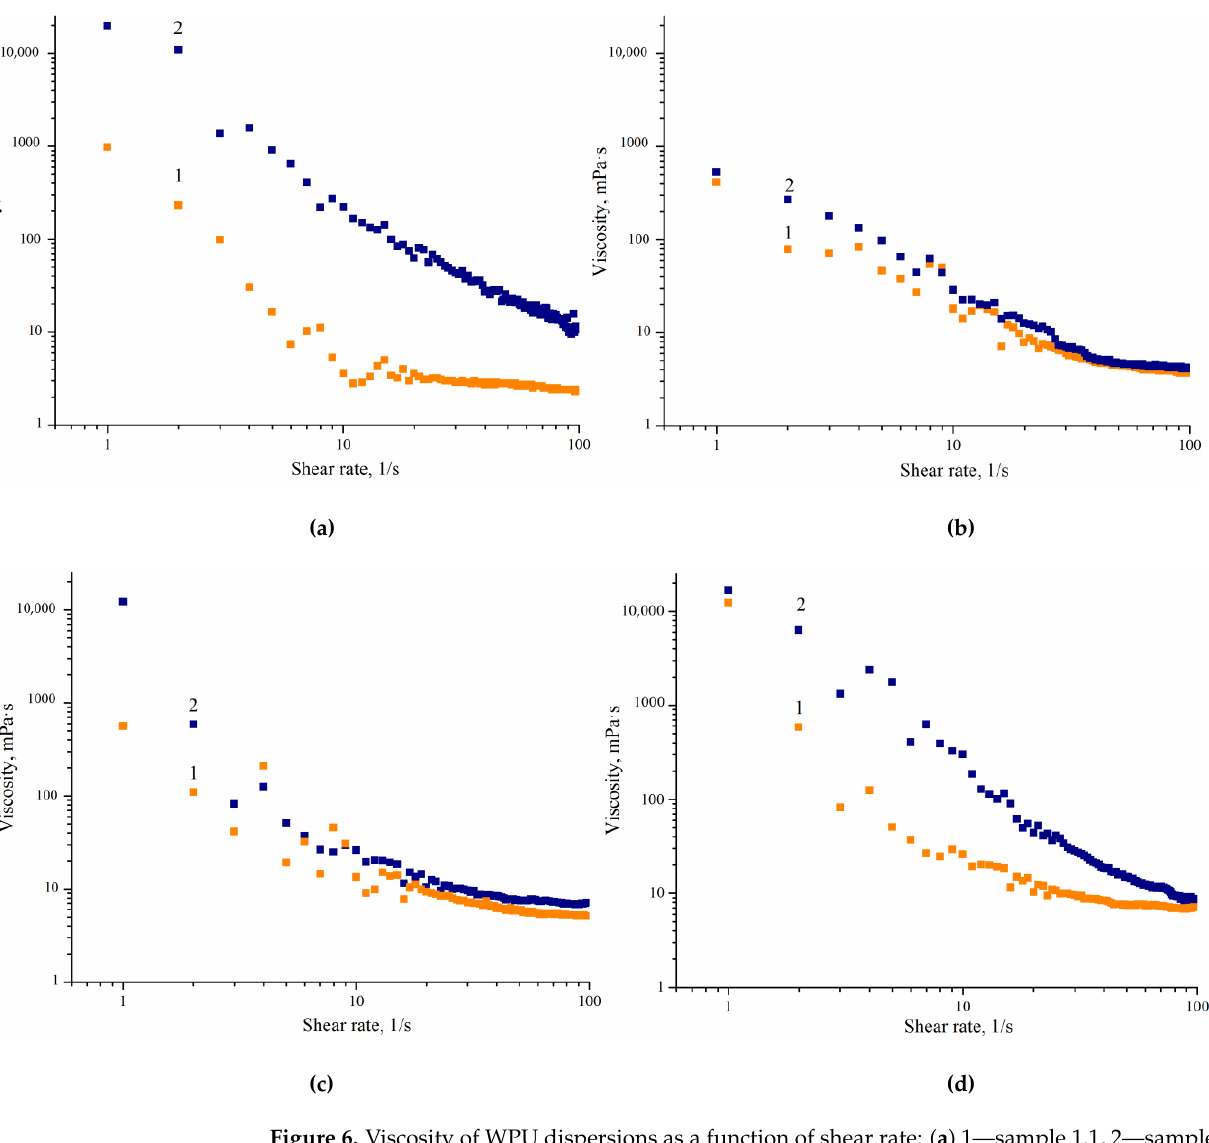
Figure 6. Viscosity of WPU dispersions as a function of shear rate: ( a ) 1 — sample 1.1, 2 — sample 2.1; ( b ) 1 — sample 1.4, 2 — sample 2.4; ( c ) 1 — sample 1.7, 2 — sample 2.7; ( d ) 1 — sample 1.7, 2 — sample 1.8. ( b ) 1—sample 1.4, 2—sample 2.4; ( c ) 1—sample 1.7, 2—sample 2.7; ( d ) 1—sample 1.7, 2—sample